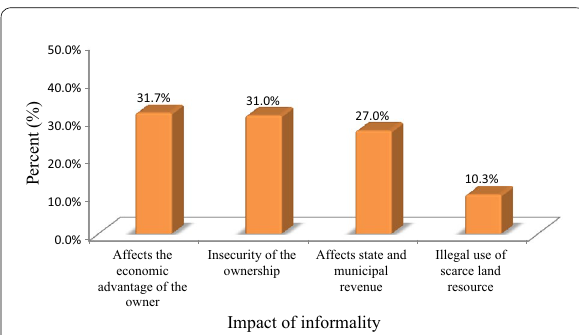
is a fast increase of informal settlements outside of city municipality boundaries. The LULCC analysis results indicated that the built-up area has shows an increasing trend over the last two decades, i.e., the built-up land use type is the only land use class that shows increasing trends in the study area, while agricultural land use was affected largely due to conversion into built-up areas. The rapid increasing of built-up areas and a fast declining of agricultural lands leads to dramatic changes in LULC classes in the study area.